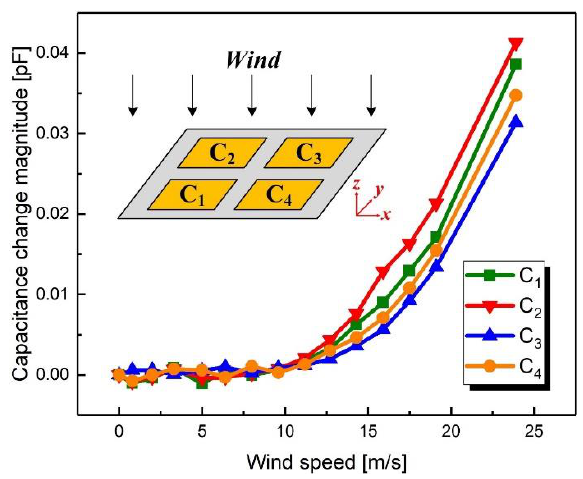
Figure 11. Measured capacitance change magnitudes when the speed was changed from 0 m/s to 23.9 m/s for the wind blowing from the positive z -axis to the negative z -axis.